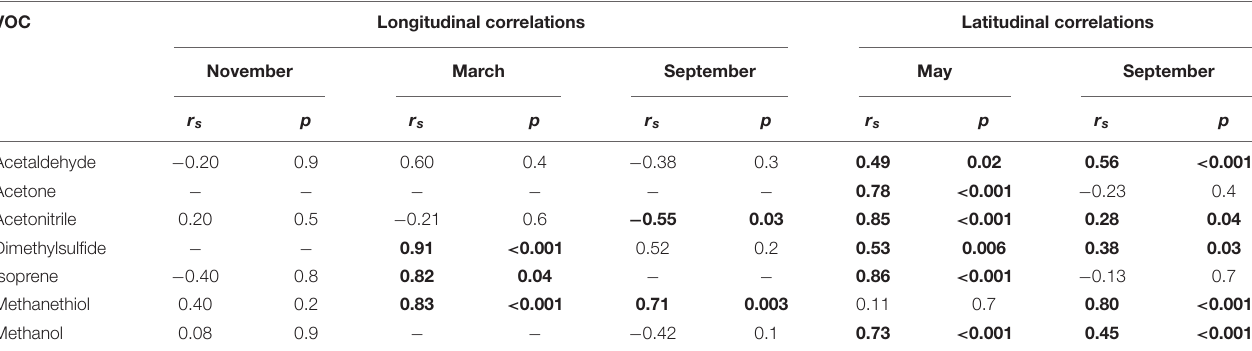
TABLE 2 | Spearman’s rank outcomes ( r s and p ) for correlations between net VOC production rates and latitude (for north-to-south gradients between 44 and 38 ◦ W) or longitude (for west-to-east gradients between 40 and 44 ◦ N) during different months. VOC Longitudinal